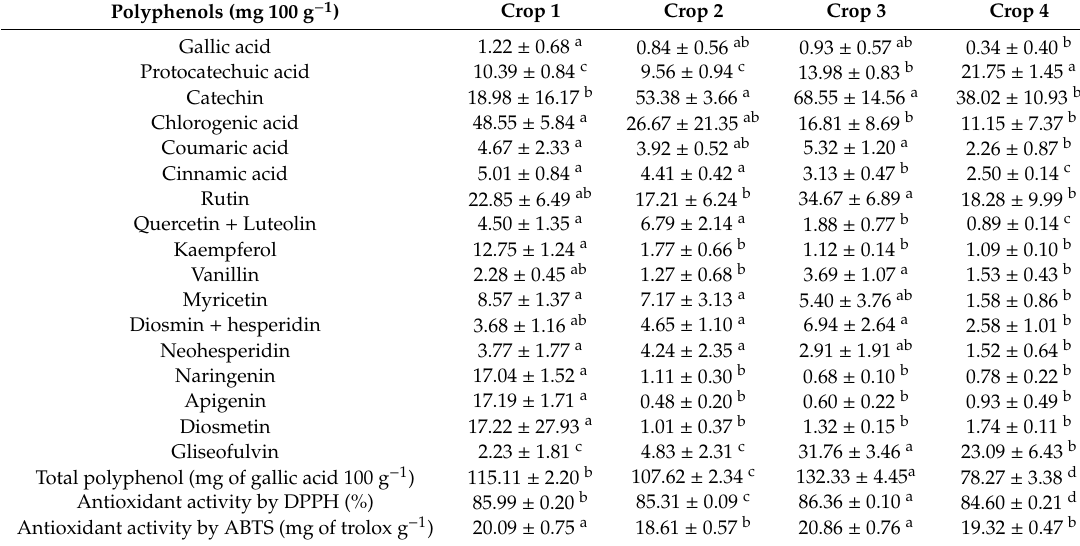
Table A1. Average values of the determination of individual polyphenols, total polyphenols, and the antioxidant activity by DPPH and ABTS in each of the